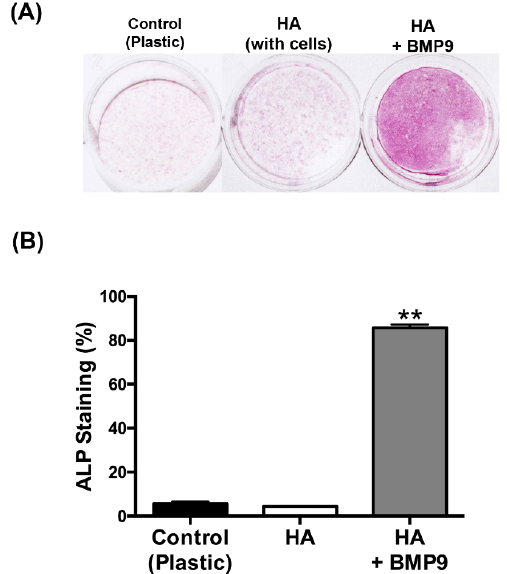
Figure 4. ( A ) Alkaline phosphatase staining at seven days of ST2 cells seeded on (1) control tissue culture plastic (TCP), (2) control HA and (3) HA in combination with 100 ng/mL of rhBMP9. ( B ) rhBMP9 significantly and markedly enhanced ALP staining when compared to both control TCP and control HA groups (** denotes significantly higher than all other treatment modalities, p < 0.05).